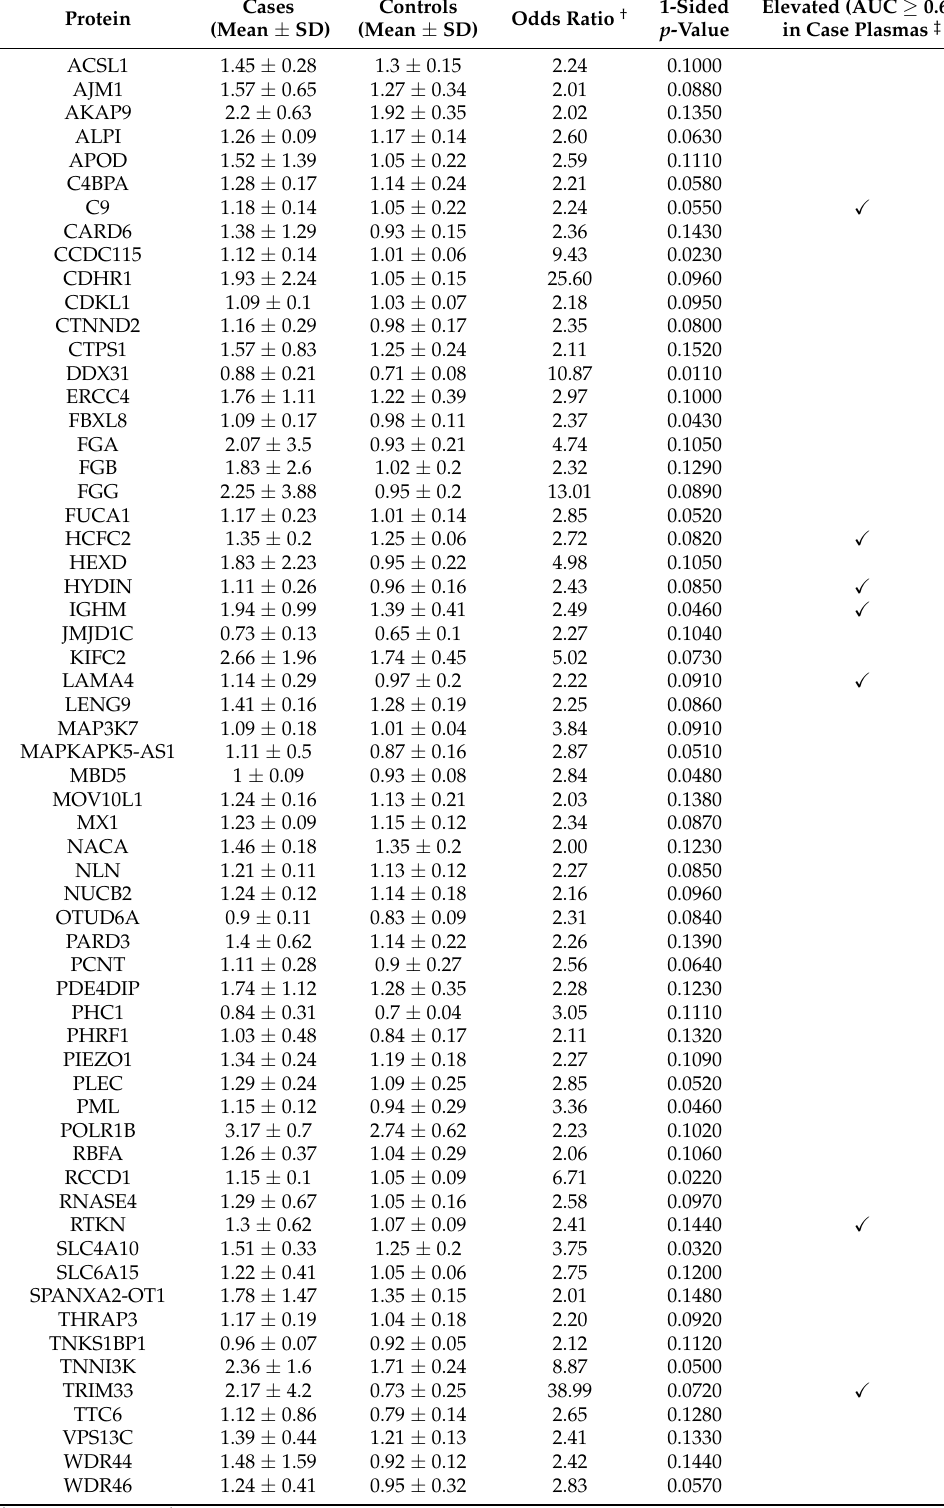
Table 4. The 61 circulating proteins that exhibited an Odds Ratio >2 for SCLC lung